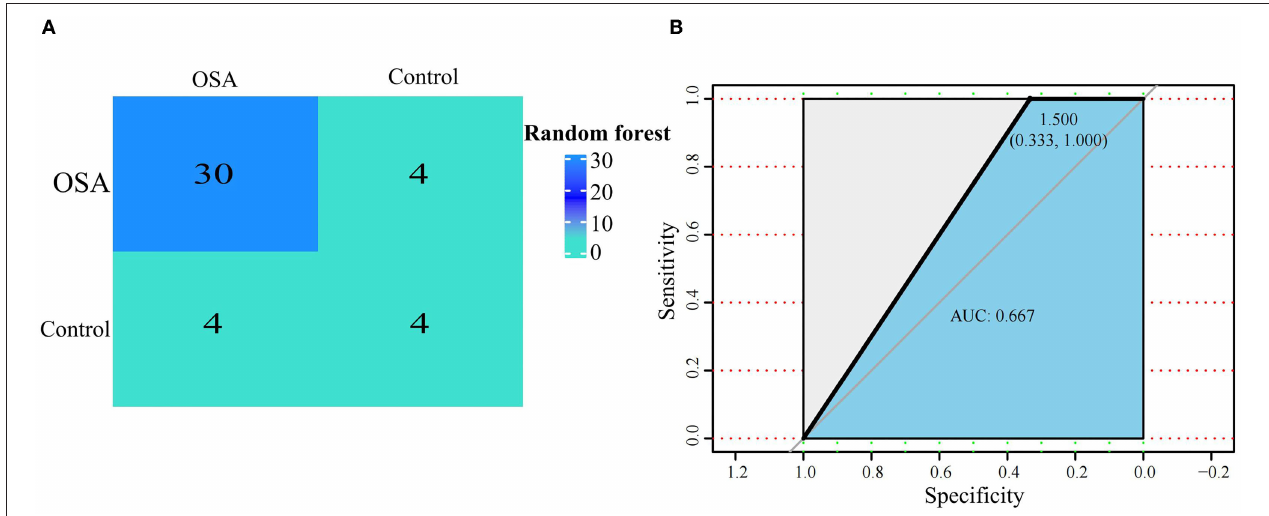
FIGURE 5 | Establishment of a random forest model based on hypoxia-related DEGs in OSA. (A) Confusion matrix of GSE135917 using the random forest model. (B) The diagnostic performance of the random forest model by ROC curve